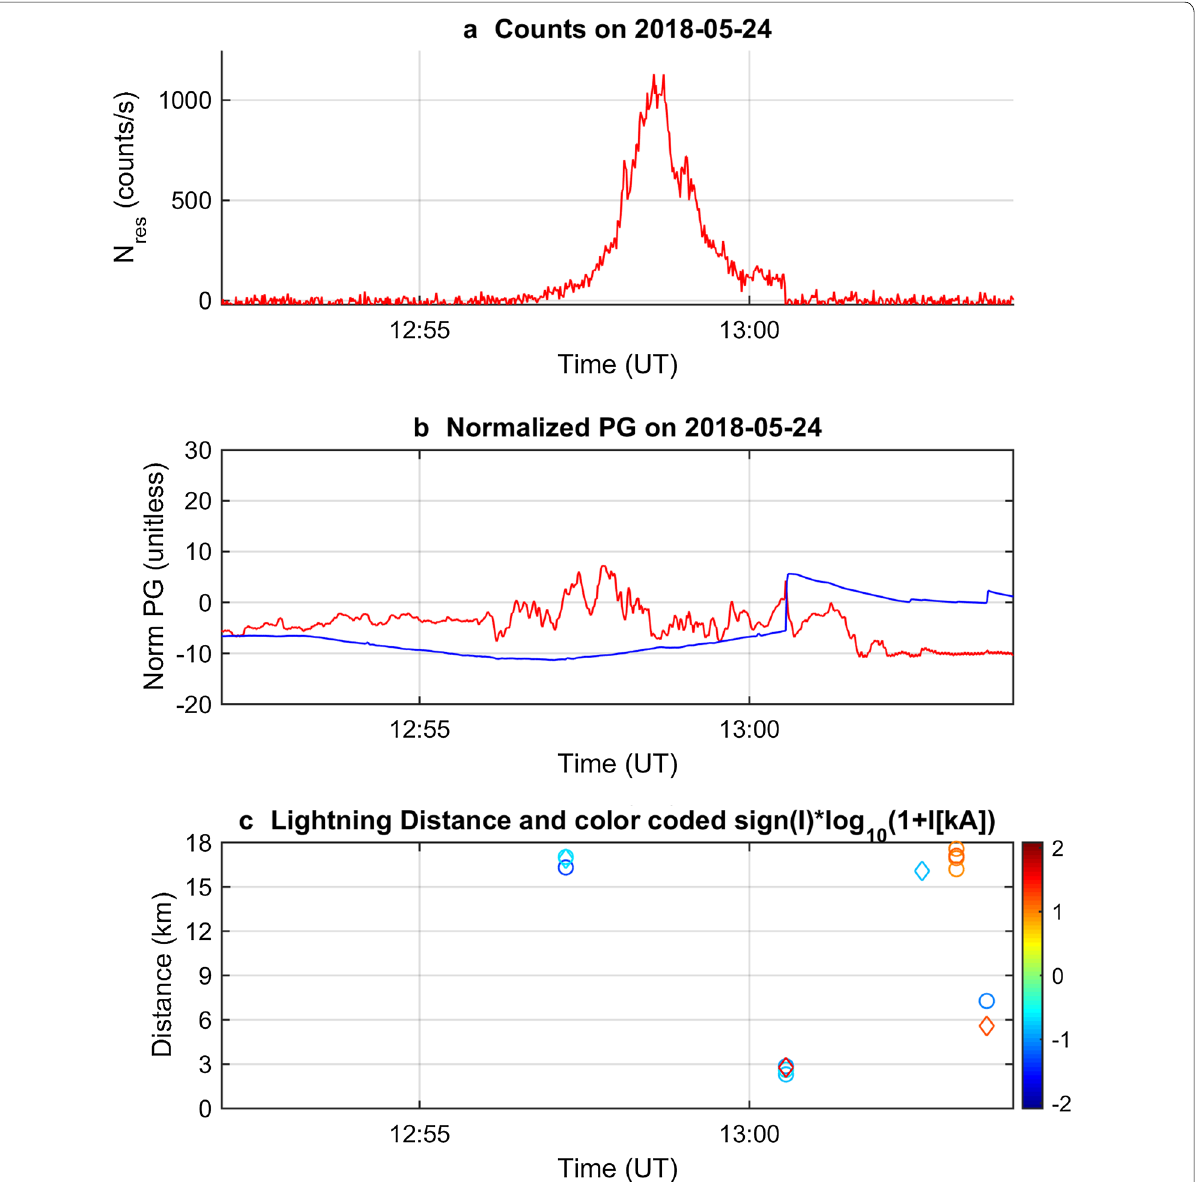
Fig. 6 Event recorded on 24 May 2018 around 12:58 UT. a Residual counts at Lomnicky peak by red. b Normalized PG at Lomnicky peak (red) and Skalnate Pleso (blue). c Lightning distances from Lomnicky peak as recorded by EUCLID lightning detection network; CG discharges are by diamonds, IC by circles, peak current I is color-coded; the color approximately corresponds to the common logarithm of the peak current in kA, sign of the current is